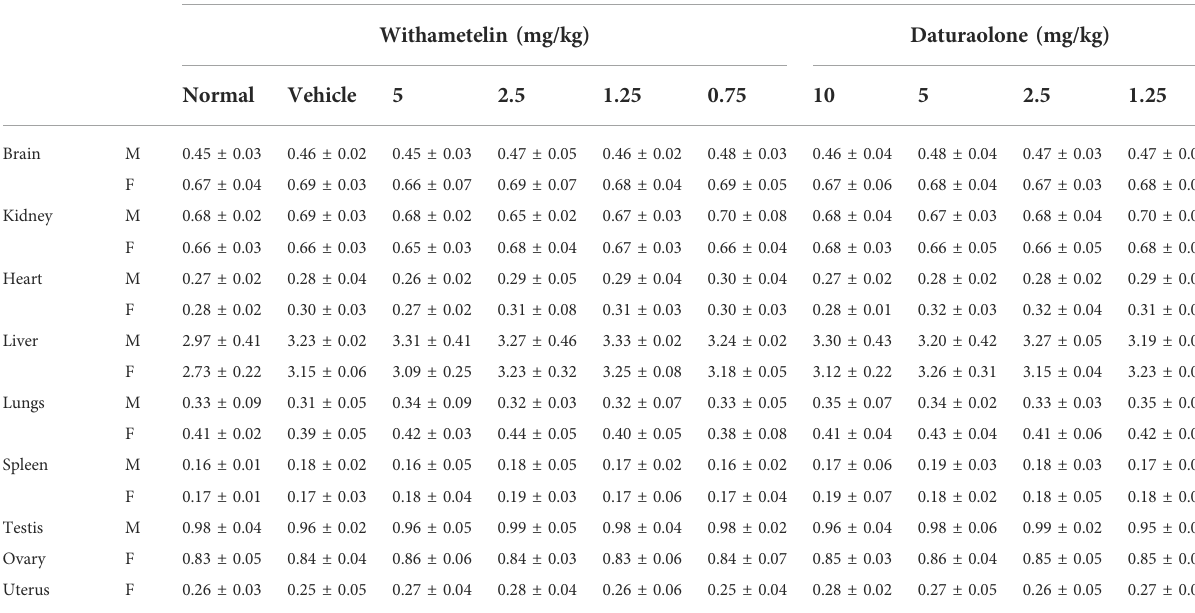
TABLE 5 Relative organ weight values of different organs of withametelin and daturaolone after necropsy.